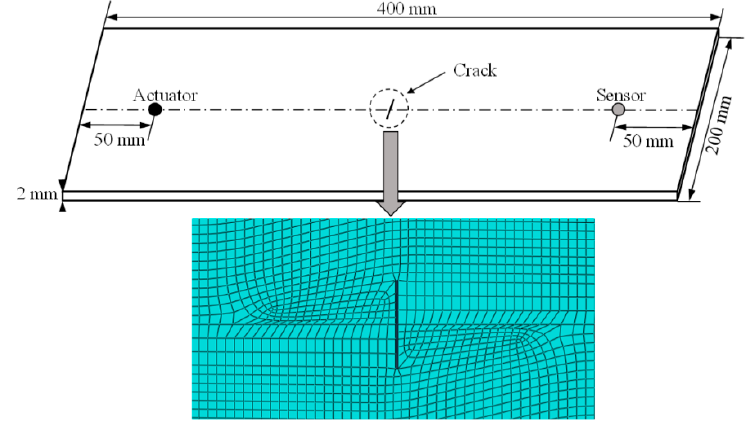
Figure 2. The dimension of the plate structure, crack location, and mesh of the 3D finite element model. Table 1. Mechanical properties of 2024-T3 aluminum alloy plates.